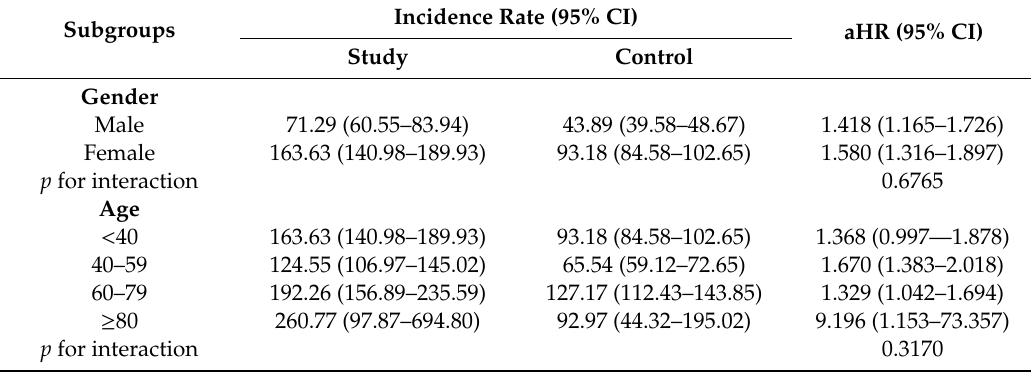
Figure 2. The cumulative probability of dry eye disease between the study and control groups. Table 4. The sensitivity analysis for the adjusted hazard ratio stratified by follow-up time of gender and age groups.